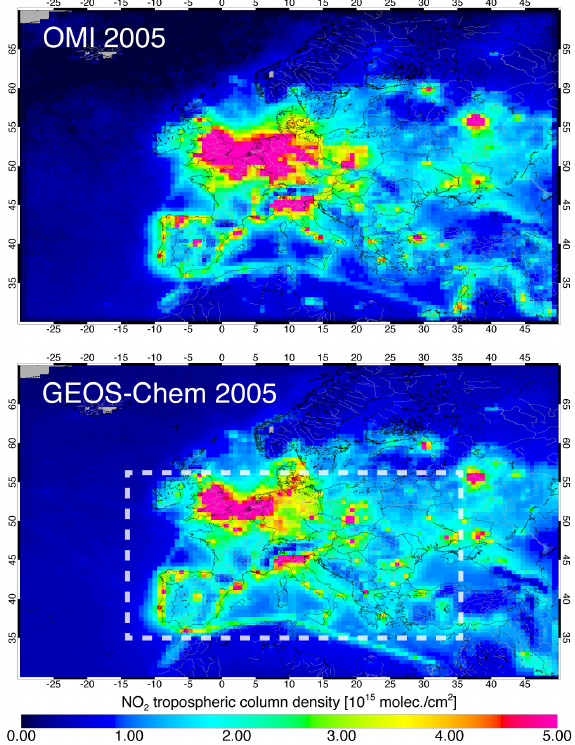
Fig. 3. Annually averaged tropospheric NO 2 columns on a 1 / 2 ◦ × 2 / 3 ◦ resolution for OMI (DOMINO2_GC, top) and GEOS-Chem (bottom). Pixels with cloud radiance fraction above 0.5 and surface albedo above 0.2 are excluded to reduce retrieval errors. Further- more the outer two pixels on each side of the swath are excluded. OMI pixels are regridded to the GEOS-Chem nested horizontal grid (1 / 2 ◦ × 2 / 3 ◦ ), requiring a grid cell coverage of over 75% and more than three observations per grid cell. The dashed rectangle indicates the area over which spatial averages of OMI and GEOS-Chem are compared in Sect.